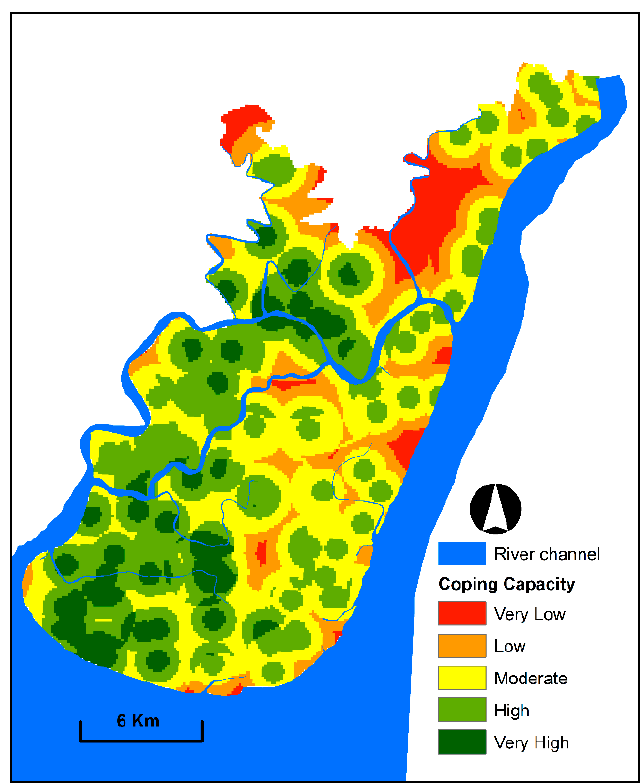
Figure 8. Coping capacity map exhibiting spatial patterns and the degree of coping capacity against floods.